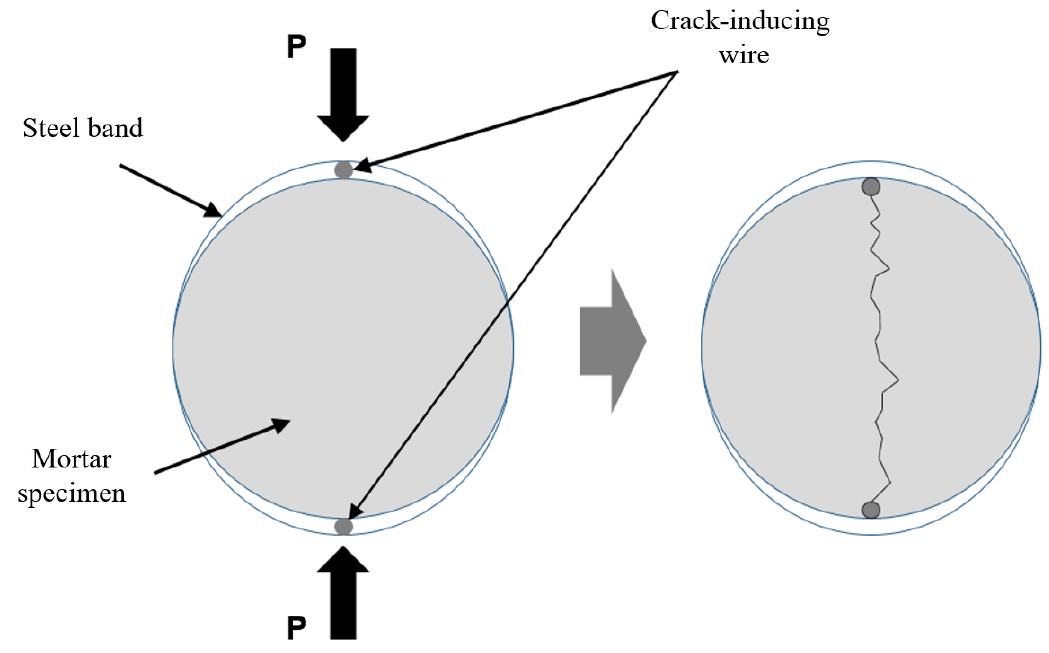
Figure 2. Scheme of splitting tensile test.